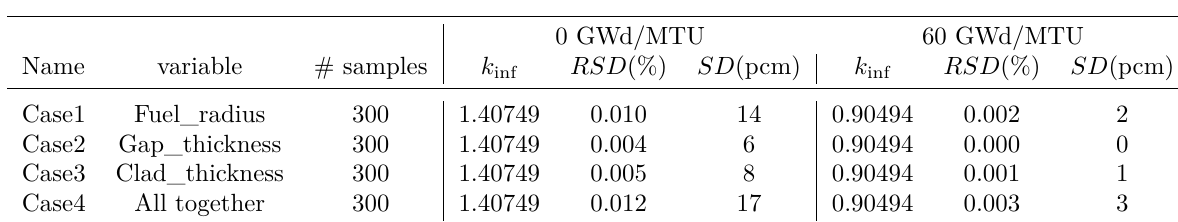
Table 4. Variables sampled for each study case and results of UQ with the contributors to uncertainty in k